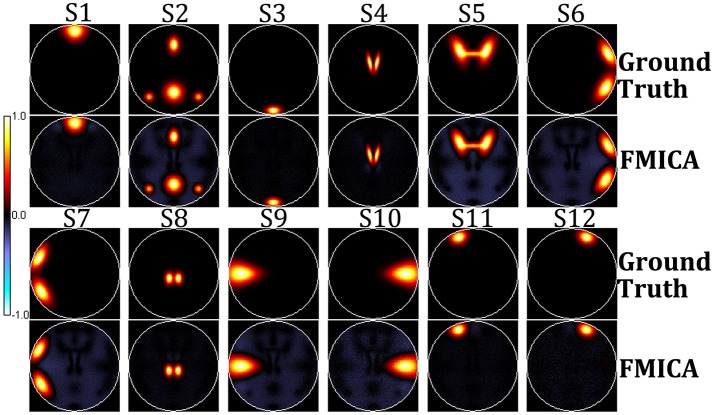
The simulated ground truth sources and the intragroup sources estimated by FMICA.